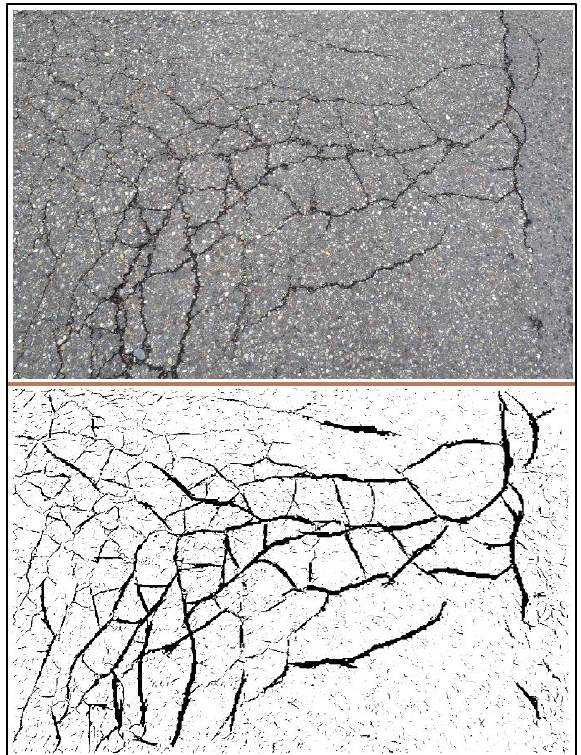
Figure 5. Original image (top), discovered potential crack pixels by LF, (union on all levels of detail, bottom) Due to the high sensitivity of LBP, edges caused (mostly) by bright aggregates which are in the vicinity of the crack area are connected to the crack pixels.